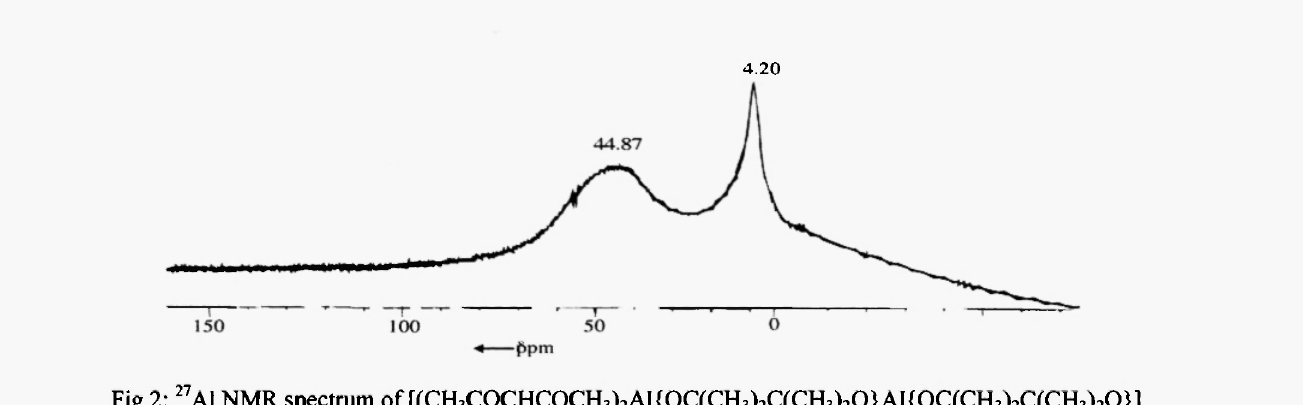
Fig.2: 27 A1 NMR spectrum of [(CH 3 C0CHC0CH3)2AI{0C(CH3)2C(CH3)20}AI{0C(CH 3 )2C(CH3)20}]